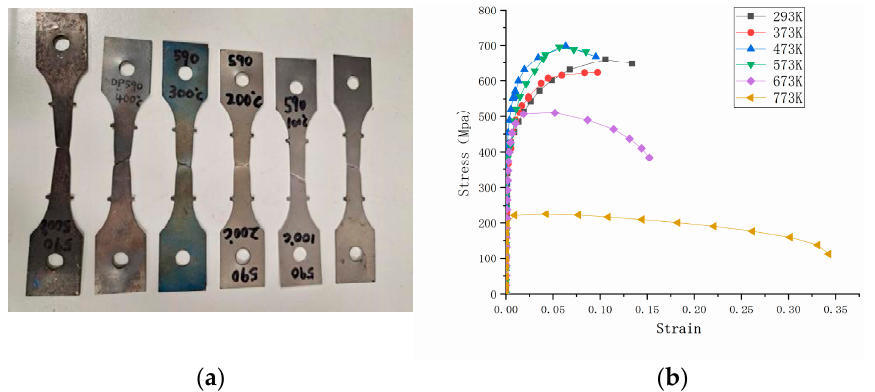
Figure 2. ( a ) Specimen test diagram and ( b ) engineering stress–strain curve of DP590 steel at different temperatures.